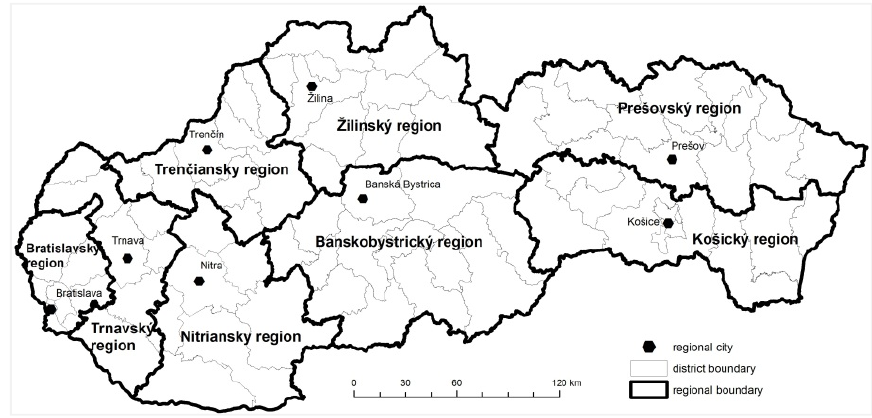
Figure 3. Regional divisions of Slovakia.